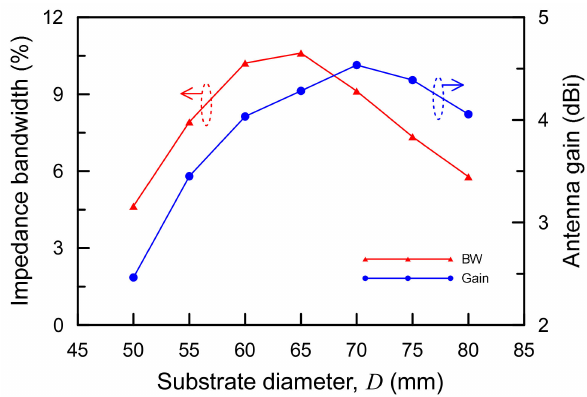
Figure 10. 10-dB impedance bandwidth and realized antenna gains of the proposed antenna with a substrate diameter of D variation from 50 mm to 80